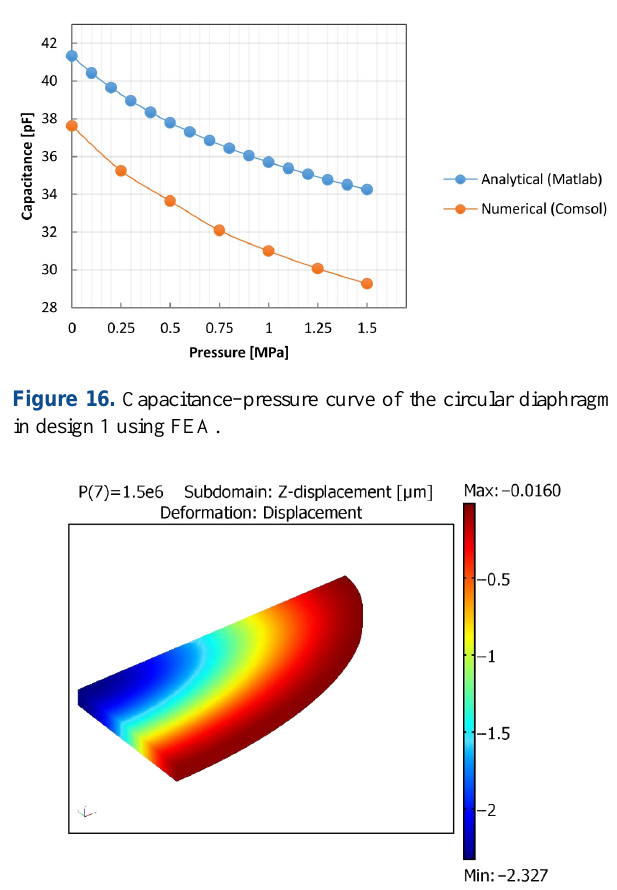
Figure 19. Temperature effect on the output signal in design 3 using